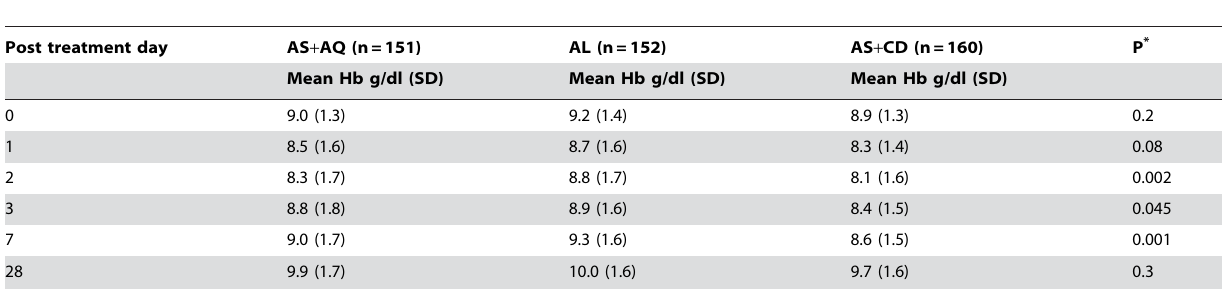
Table 4. Haemoglobin concentration during the post treatment period in the study groups.